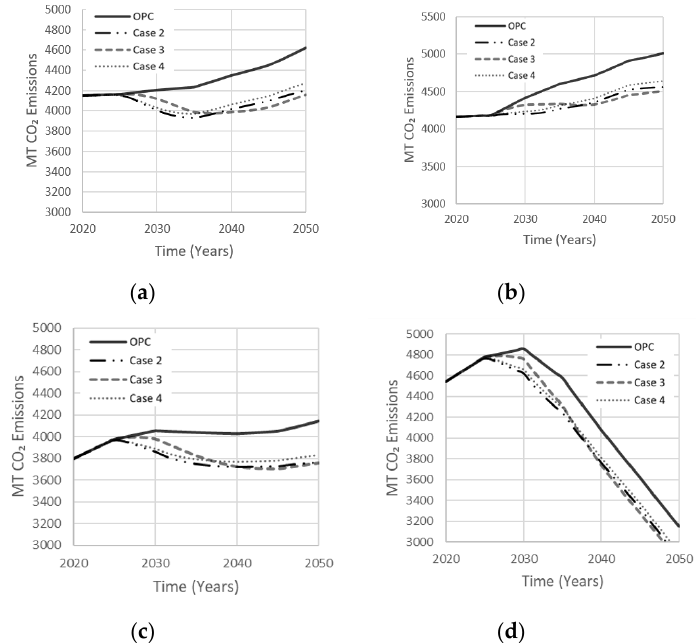
Figure 17. Effect of idealistic AAB cases on net emissions released in ( a ) Low Variability Scenario; ( b ) High Variability Scenario; ( c ) Carbon Tax Increase Scenario; ( d ) Population Stabilization Scenario.